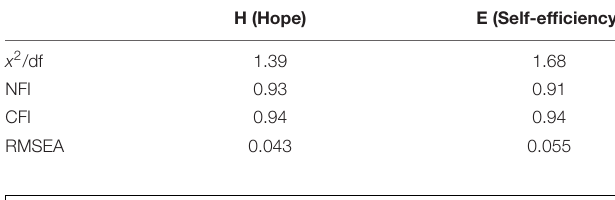
TABLE 5 | Confirmatory factor analysis results of two sub-scales.